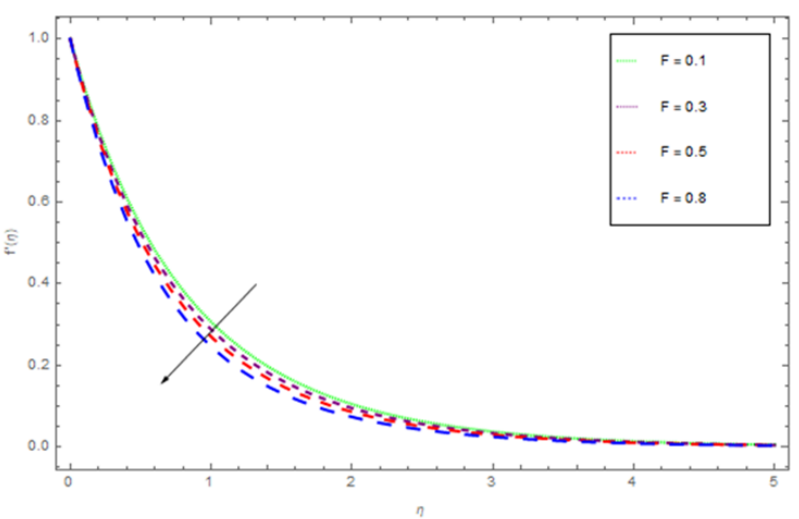
(cid:48) ( η ) with k = 0.6, F = 0.5, λ = 0.3, γ = 0.4. 1 , for M